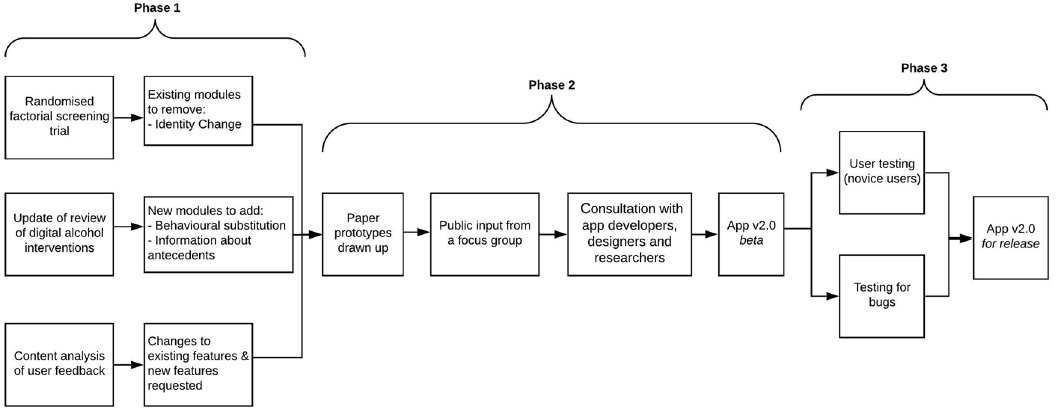
Figure 1. Process of refining the Drink Less